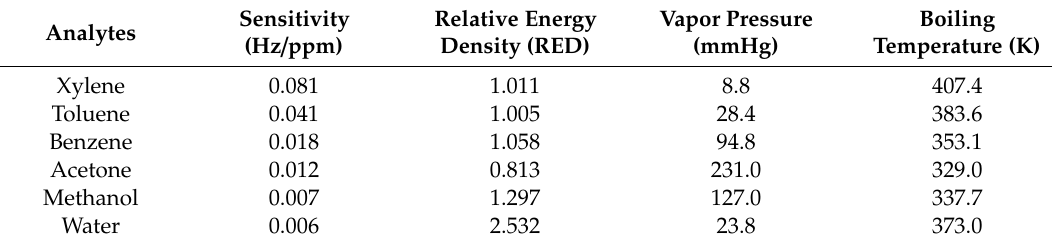
Table 1. Relative Energy Density (RED) and analyte vapor pressure used in this study.